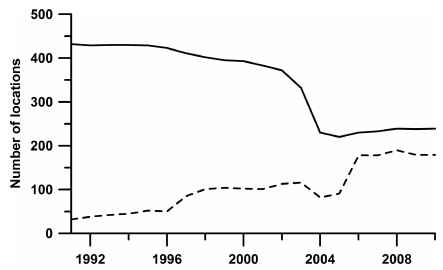
Figure 2. The number of available observation locations. Daily sta- tions – solid line; sub-daily stations – dashed line.